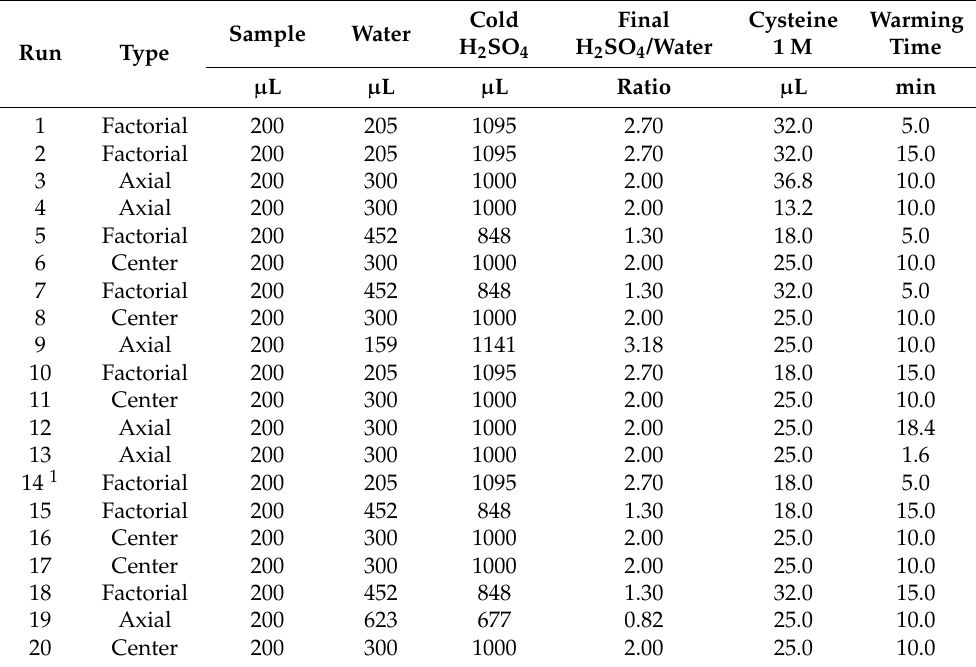
Table A1. Sample preparation and DoE runs for optimization of Dische colorimetric method.